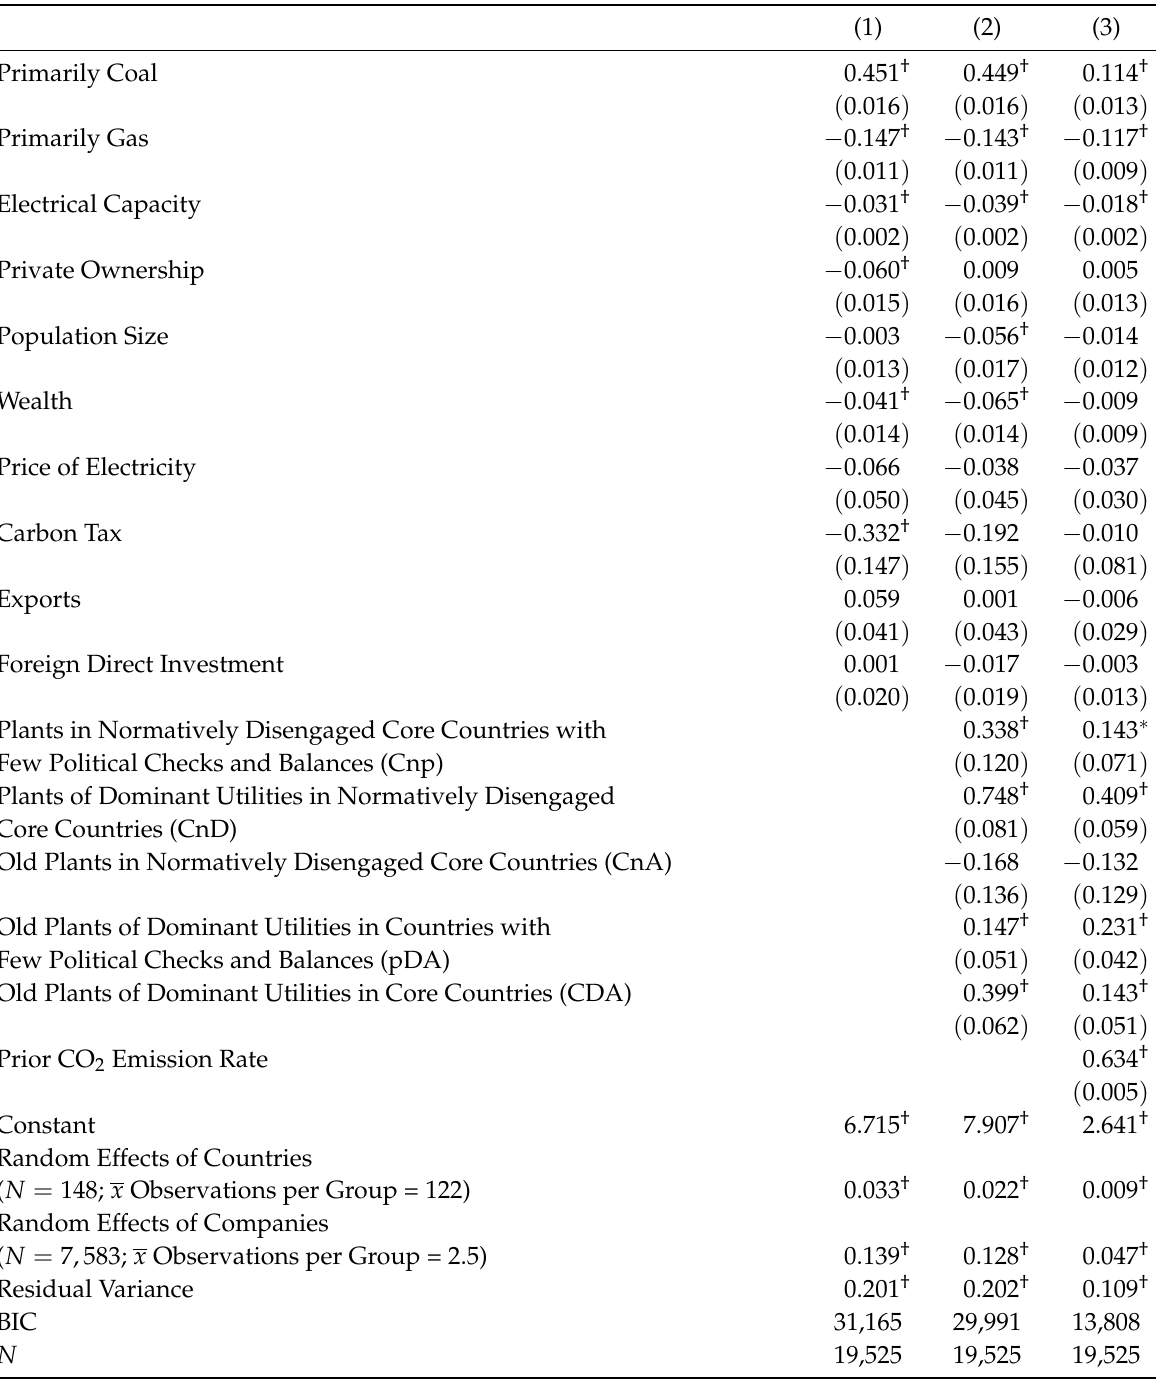
Table 7: Regression analysis of the effects of configurations on power plants’ CO